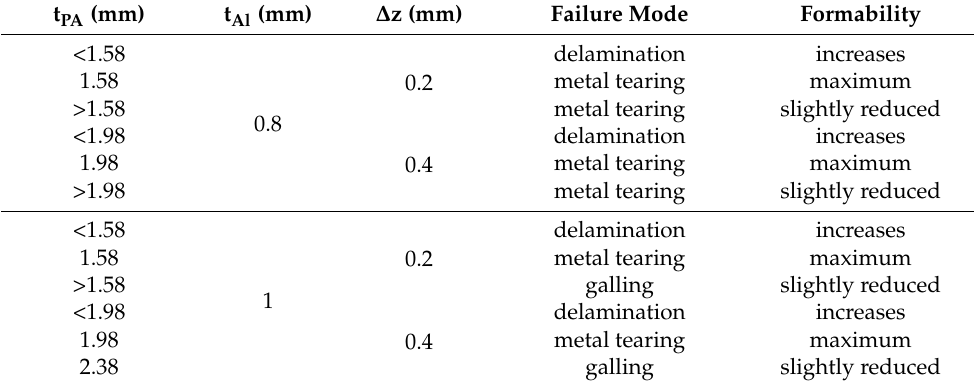
Table 3. Summary of the experimental tests performed by Davarpanah et al. [277].